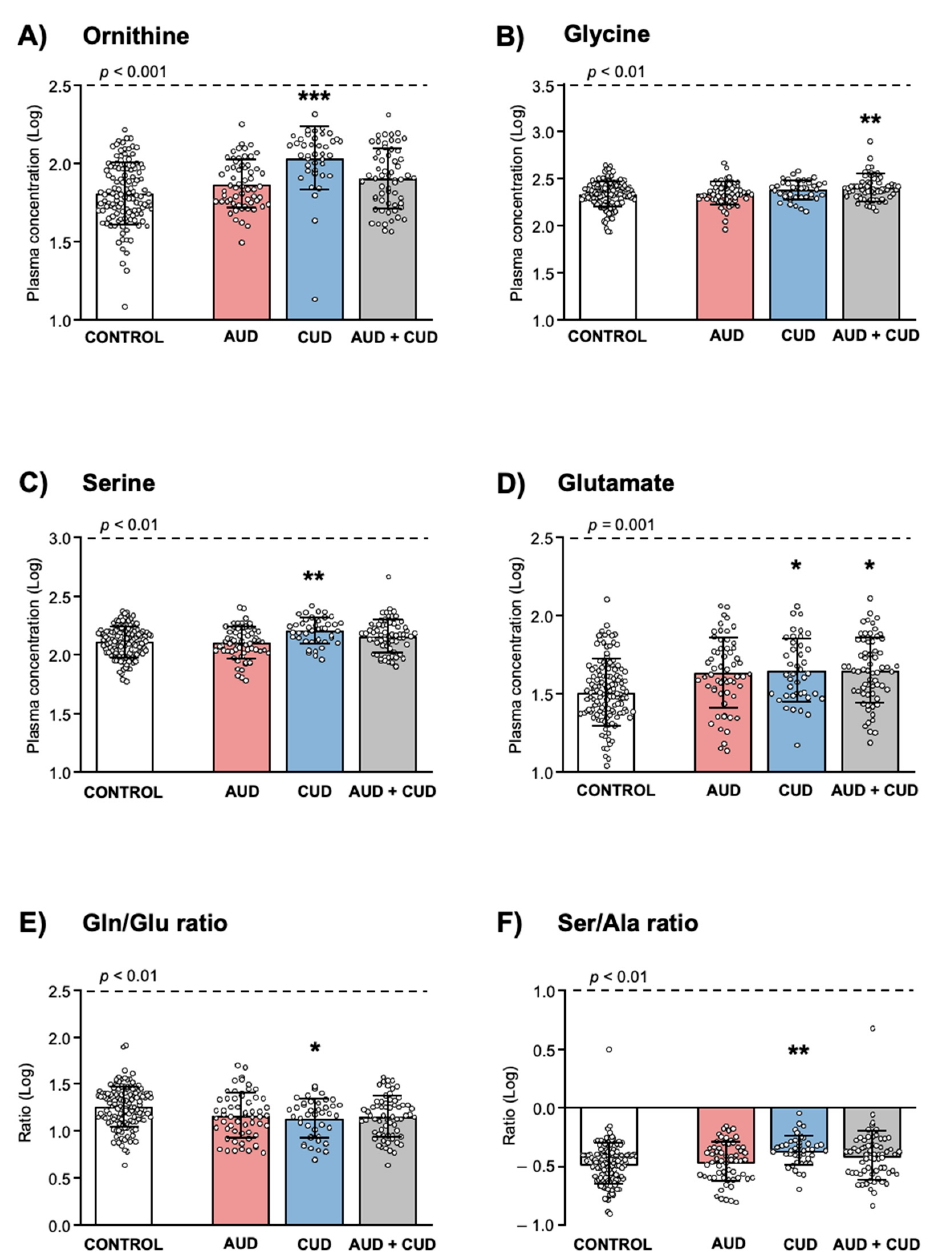
Figure 2. Plasma amino acid concentrations and ratios in relation to diagnosis of substance use dis- orders in the total sample. ( A ) L-Ornitine; ( B ) Glycine; ( C ) L-Serine; ( D ) L-Glutamate; ( E ) L-GLn/L- Glu ratio; and ( F ) L-Ser/L-Ala ratio. Dots are individual values. Bars are estimated marginal means and 95% CI of log 10 -transformed concentrations and ratios of amino acids in the control, AUD, CUD and AUD + CUD groups. Data were analyzed by two-way ANCOVA controlling for age and BMI. (*) p < 0.05, (**) p < 0.010 and (***) p < 0.001 denote significant differences compared with the control group using post hoc tests.